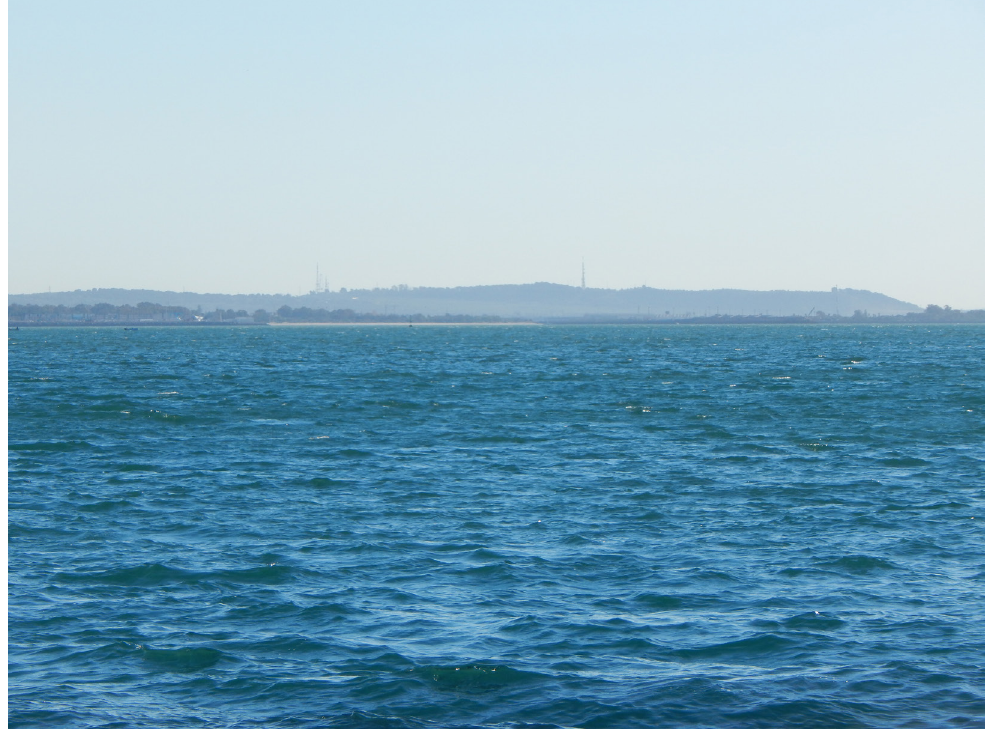
Figure 16. Detail of the good visibility from the “Piedra Rota del Tiburón” towards the continental interior. ©Authors. On the other hand, from point number 2 towards the west, the view opens out towards the Atlantic Ocean, while to the north the visual range reaches the present-day town of Rota and the North American military naval base located next to the same (fig. 17–18). In Phoenician-Punic times (at least from the 7th century BC onwards) this continental coastal strip was dotted with fishing facilities and salting factories (Sáez-Romero,